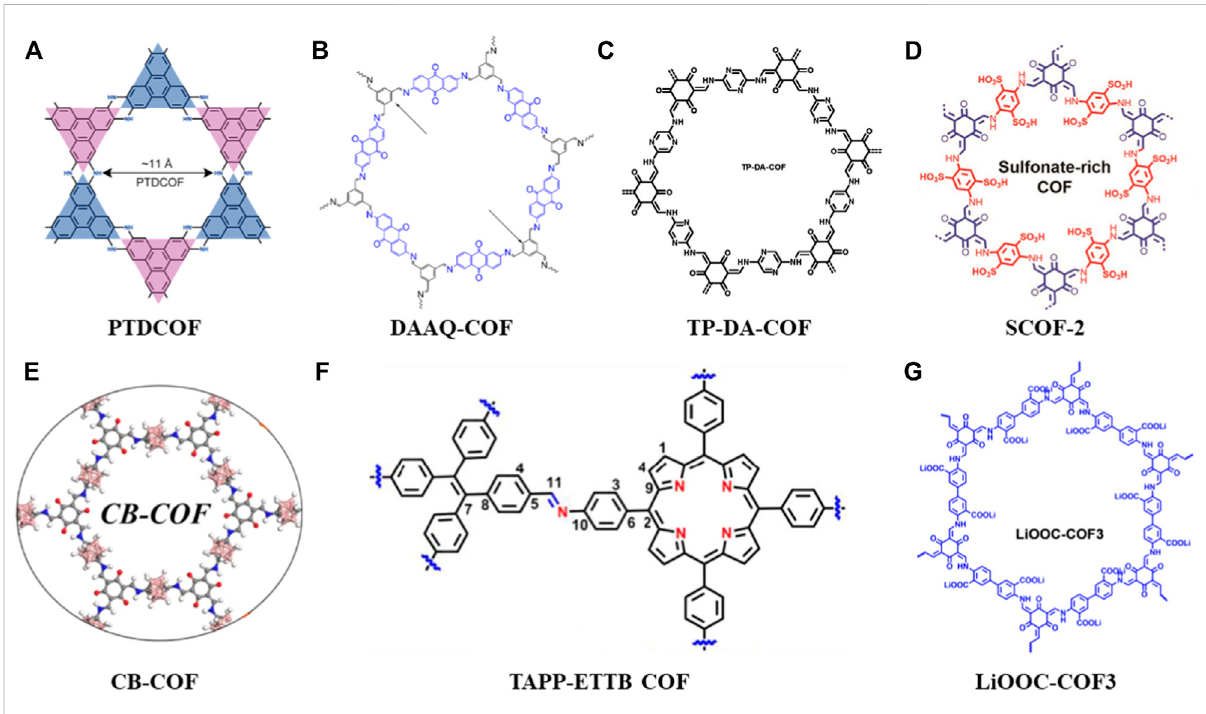
FIGURE 2 SummaryofschematicdiagramoftheCOFsinanode,separatorandsolidelectrolytesmaterials (A – G) (Zhouetal.,2021;Zhaoetal.,2021;Yang et al., 2022; Xu et al., 2021; Zhu et al., 2021; Sun et al., 2022; Zhao et al.,